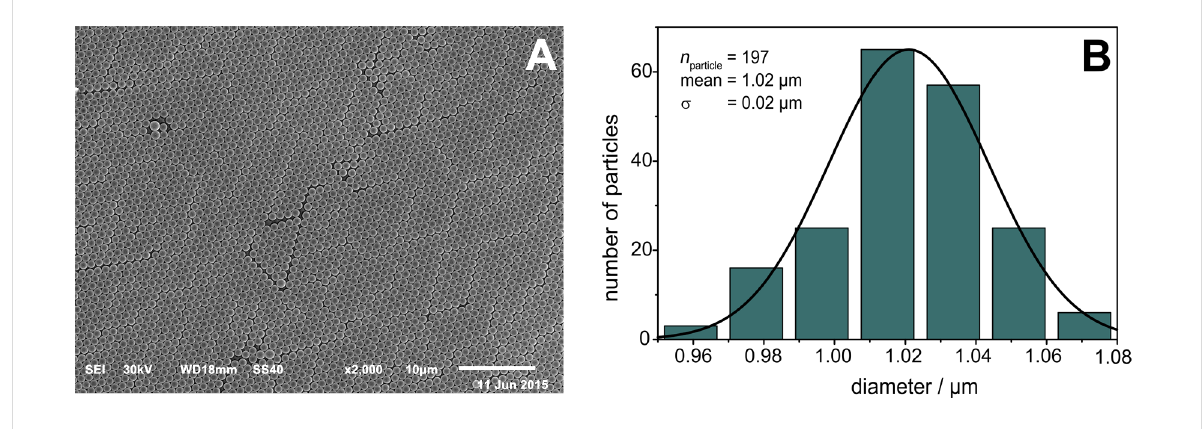
Figure 2: SEM image (A) of a densely packed monolayer of polystyrene particles with a diameter of 1.02 μ m. Substrates were covered by ~45 nm Au with a ~3 nm Ti adhesion layer. Scale bar is 10 μ m. (B) The respective particle size distribution fitted with a Gaussian function.